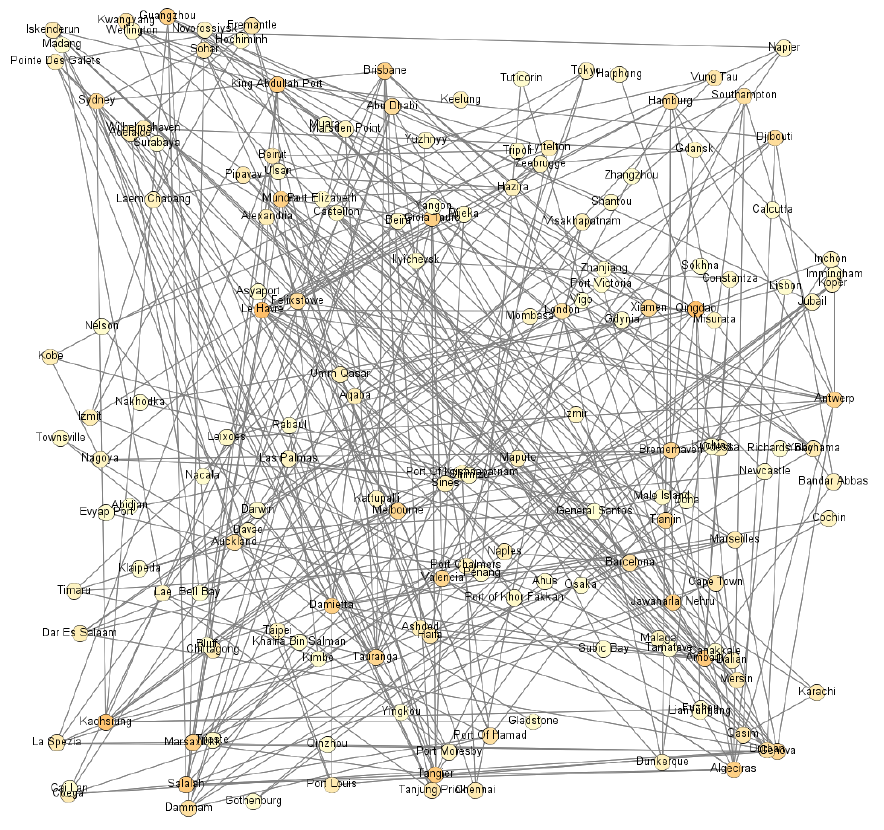
Figure 5. Network diagram after deleting the first-class and second-class ports.